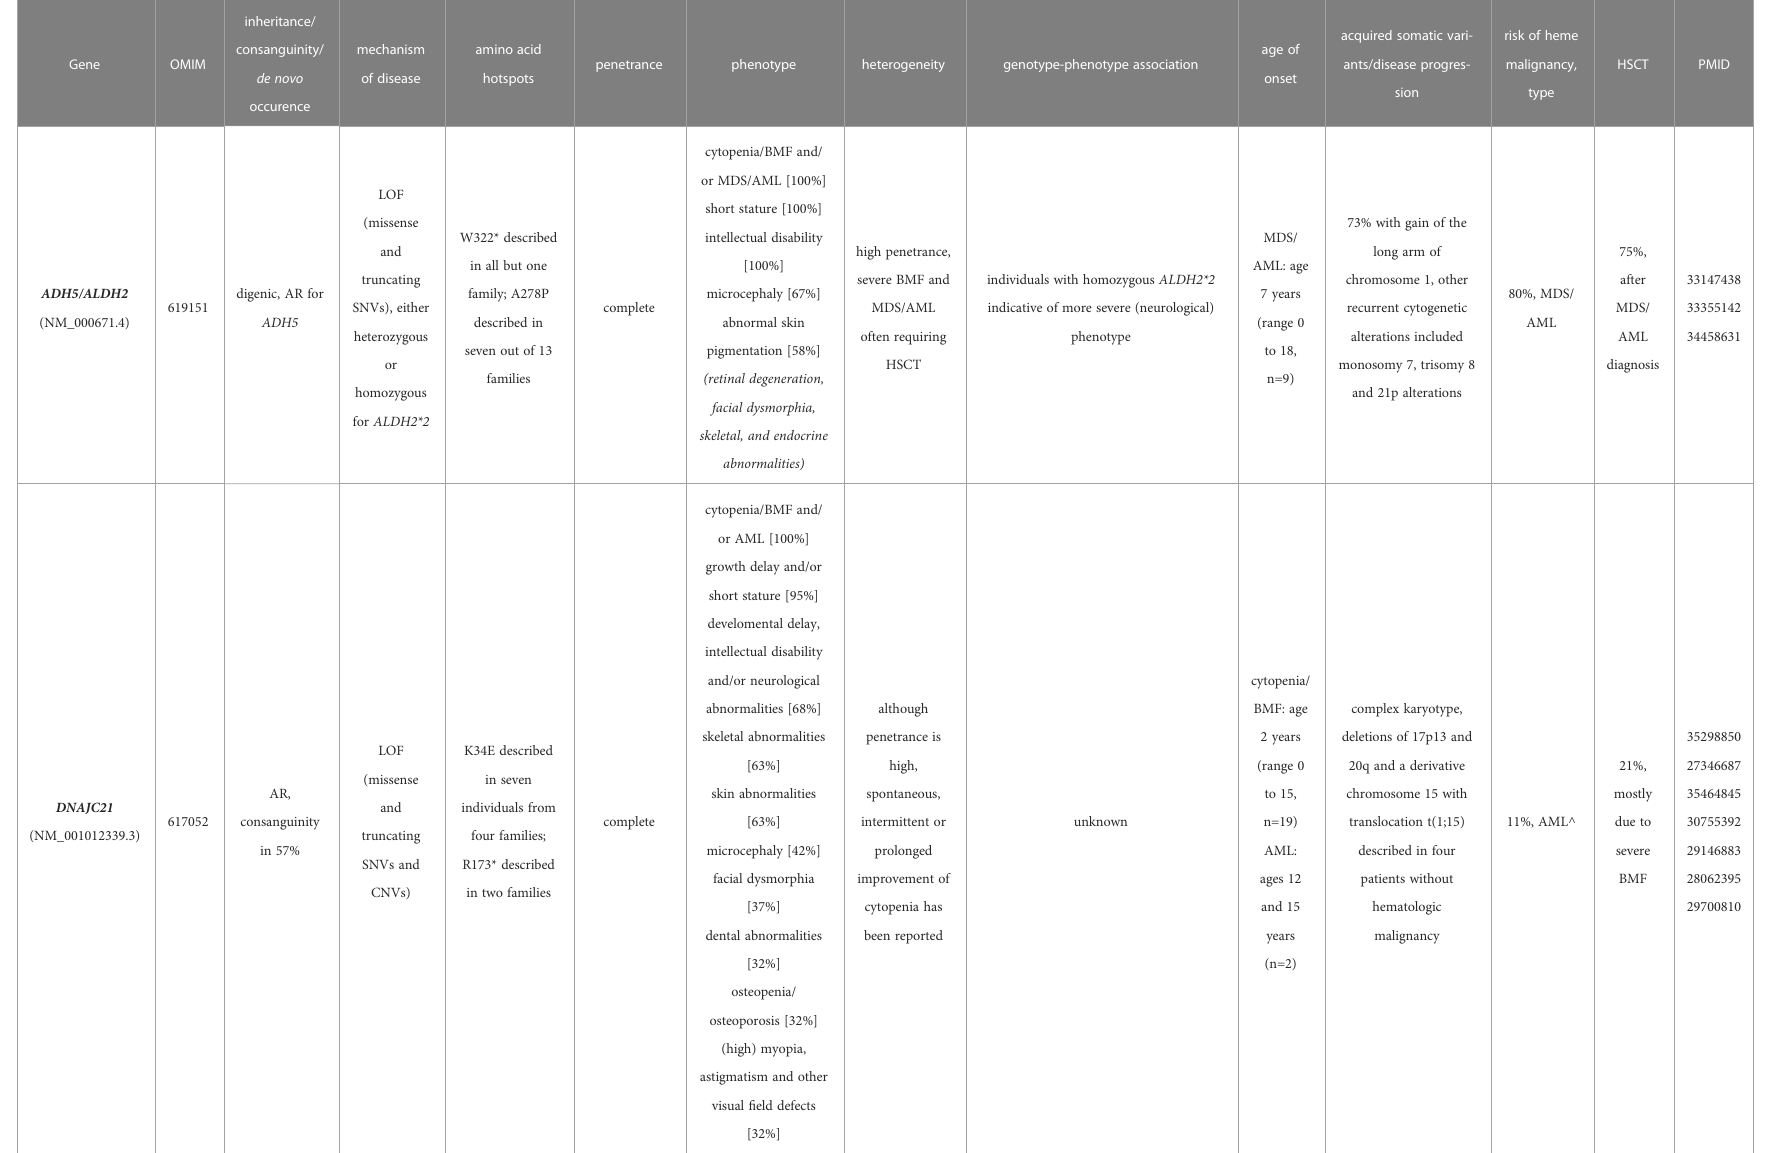
TABLE 1 Overview of emerging bone marrow failure syndromes including genetic and phenotypic features.